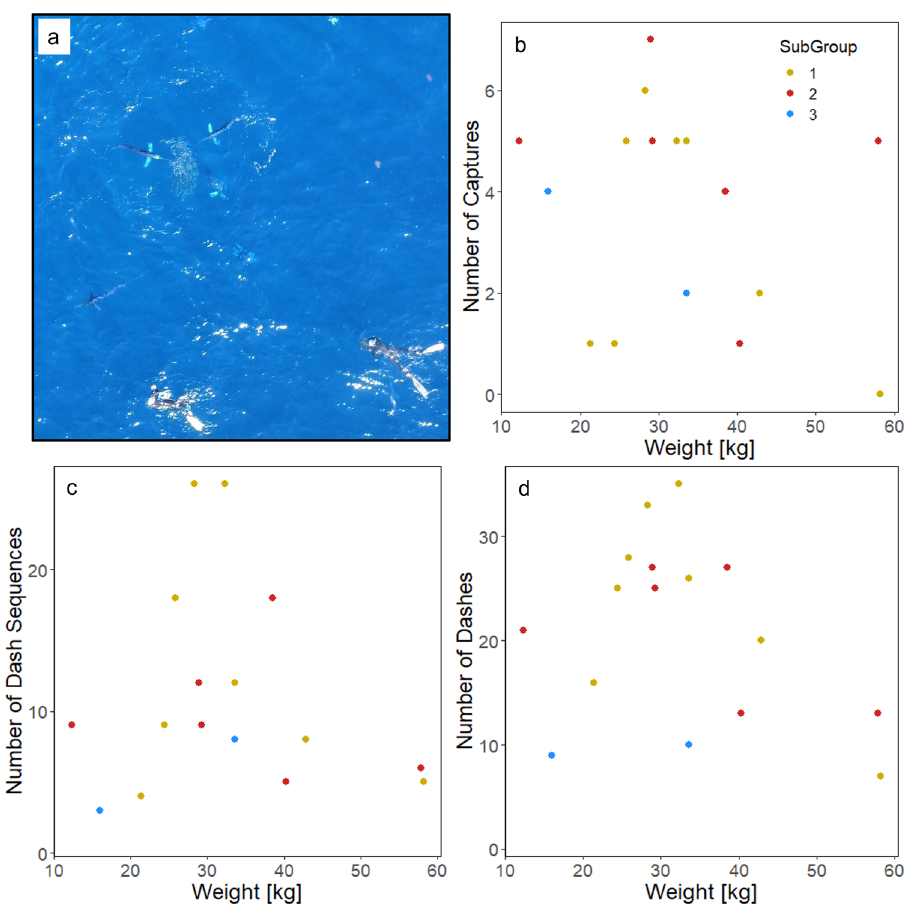
Fig. 5 Number of captures, dash sequences and dashes in relation to marlin size. a Still frame from drone video in 2019 (image created by Felicie Dhellemmes). Still frames were used to size 16/20 individually identi fi ed marlin. There was no signi fi cant relationship between individual marlin weight (kg) and number of captures ( b ), number of dash sequences ( c ) or total number of dashes ( d ) performed by individual marlin. Marlin are colour-coded with respect to subgroup - 1/3 ( ), 2/3 ( ) and 3/3 (